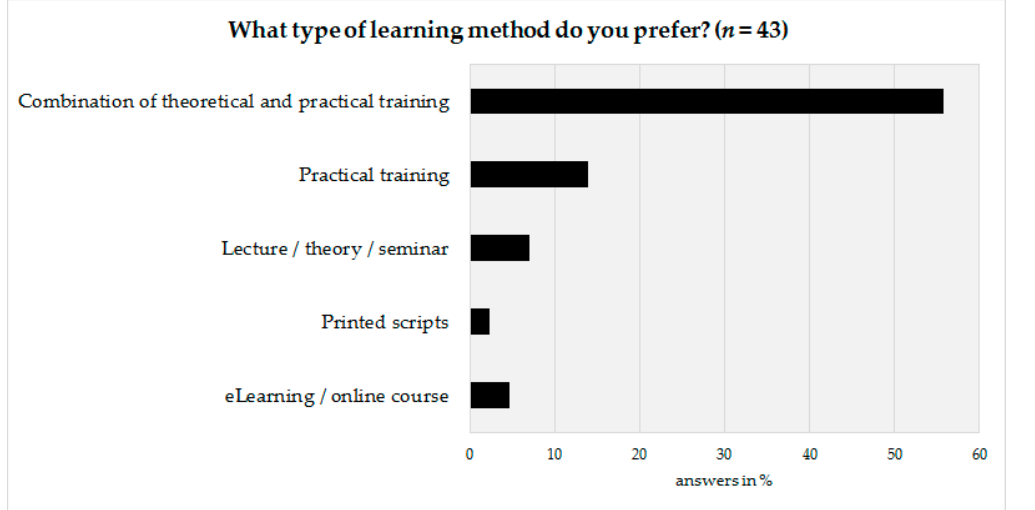
Figure 5. Preferred learning method of the technical personnel.